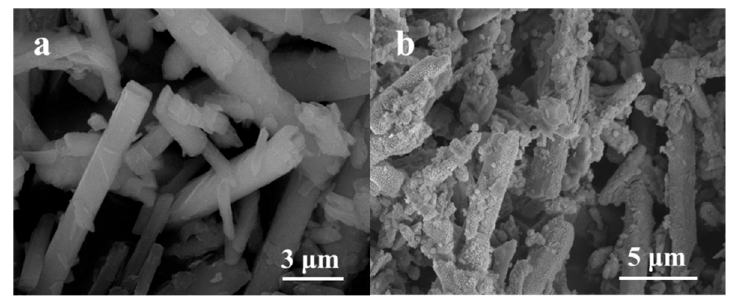
Figure 2. FE-SEM images of ( a ) K 3 Ti 5 NbO 14 and ( b ) NTNT.